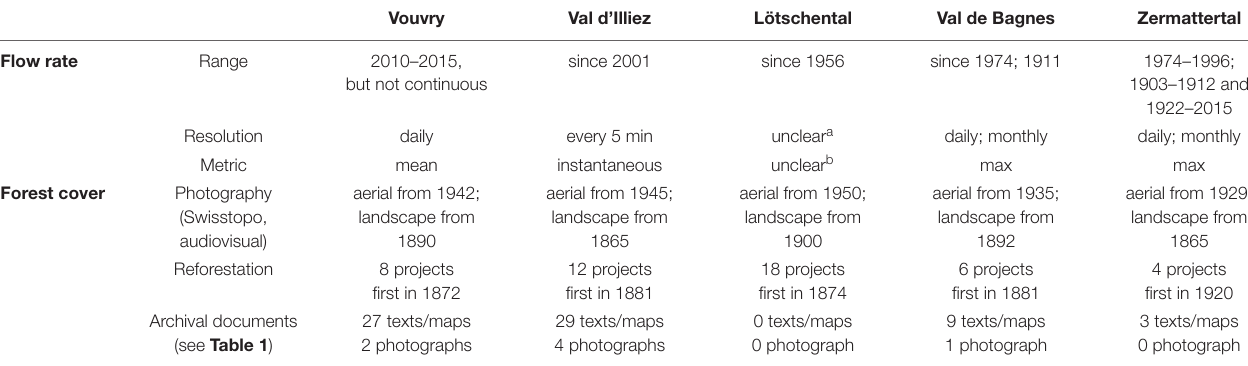
TABLE 2 | Summary of data availability of the five sub-catchments selected for intense